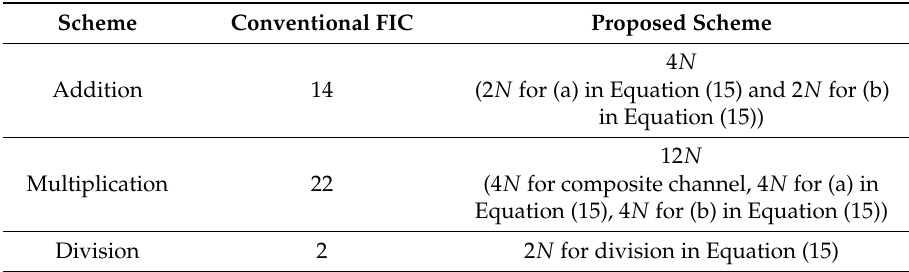
Table 4. The complexity at a destination for the conventional FIC and the proposed scheme.